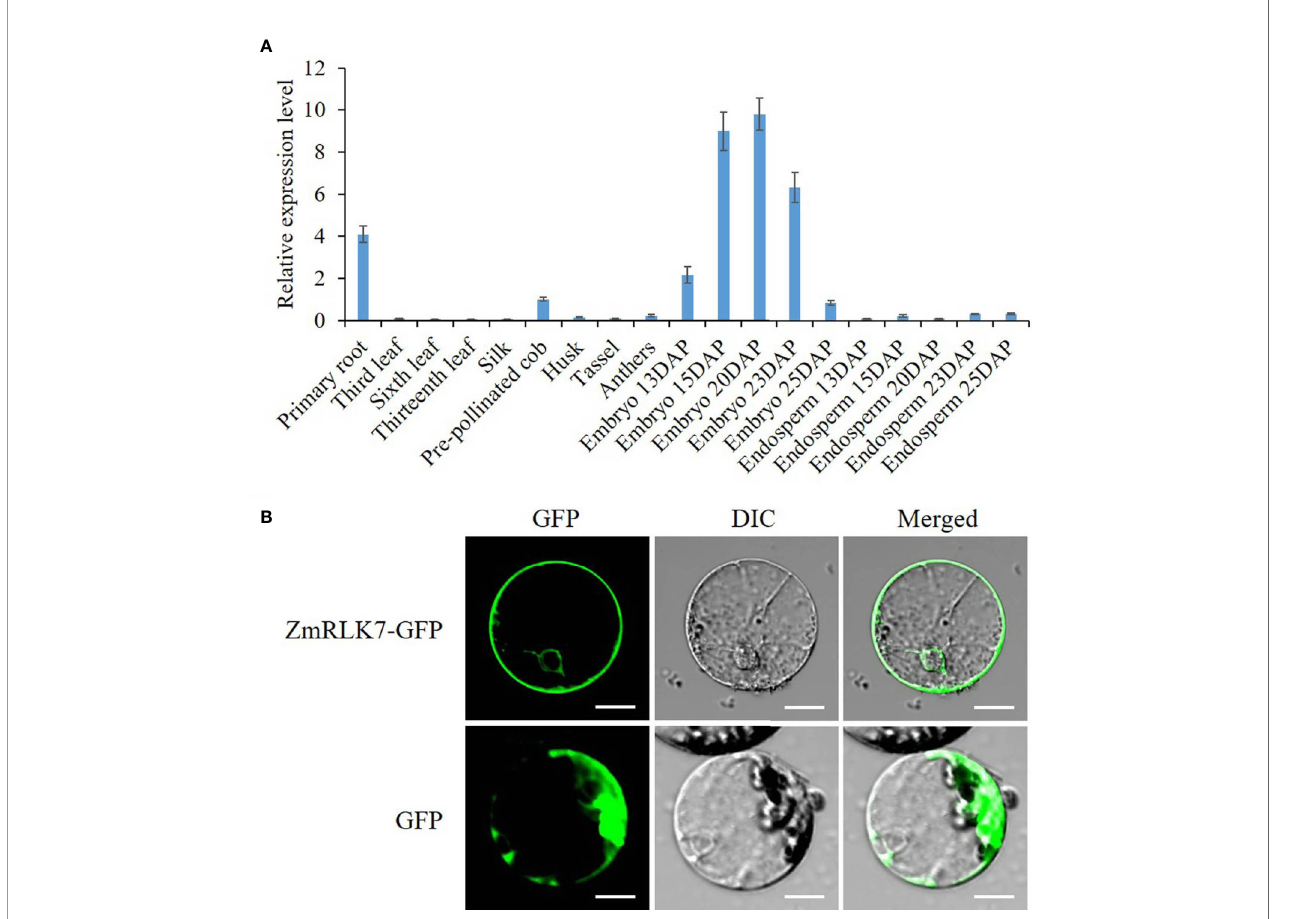
FIGURE 2 | Transcriptional analysis and subcellular localization. (A) Tissue-speci fi c expression analysis of ZmRLK7 gene by qRT-PCR. Maize ZmFPGS mRNA level was used as internal control, and expression level of ZmRLK7 in the pre-pollinated cob was used as a calibration. Values are means of three biological replicates with standard deviation (SD). DAP: days after pollination. (B) The ZmRLK7 protein were localization to both the plasma and nuclear membranes. GFP and the fusion protein ZmRLK7-GFP under the control of the CaMV35S promoter were transiently expressed in maize mesophyll protoplasts. DIC means differential interference contrast. Bars = 10